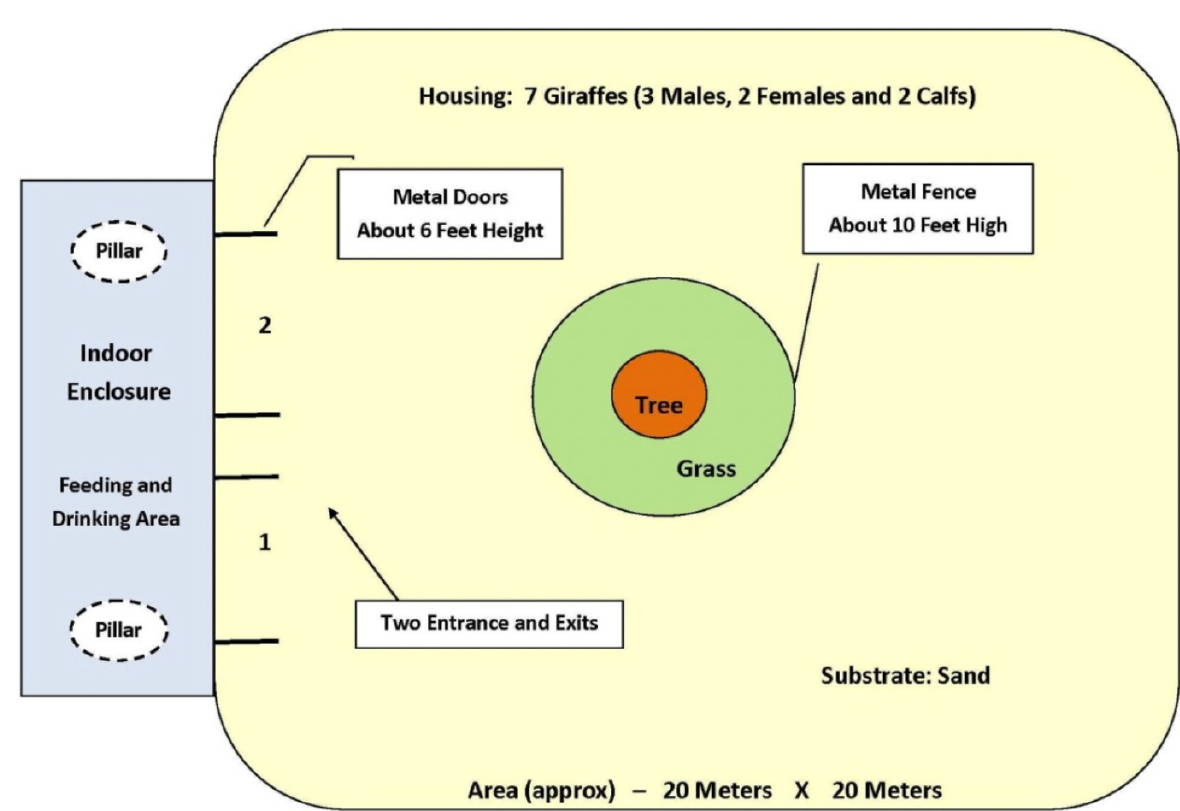
Figure 1. Layout of the Giraffe Enclosure at Zoological Garden Alipore, India.